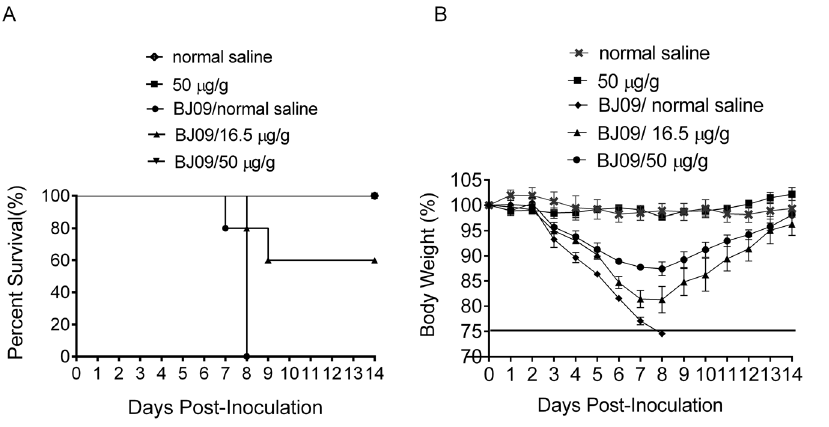
Figure 5. Characterization of Cryptoporus volvatus extract efficacy in a mouse model of H1N1/09 influenza virus infection. (A) Survival rate and (B) Weight changes of mice. The dashed line indicates 75% of initial body weight, and data are presented as mean ¡ SD. Mice infected with or without H1N1/09 influenza virus were treated with the extract or with saline. Each group contained five BALB/c mice. Body weight and survival status were checked daily. Mice were euthanized upon the loss of 25% of their initial body weight. normal saline (no virus as negative control group); 50 m g/g (no virus as extract control group); BJ09/normal saline (virus infection (10 3.5 pfu) control group); BJ09/16.5 m g/g (virus infection (10 3.5 pfu) and treated with low-dosage extract group); BJ09/50 m g/g (virus infection (10 3.5 pfu) and treated with high-dosage extract group). Data are presented as mean ¡